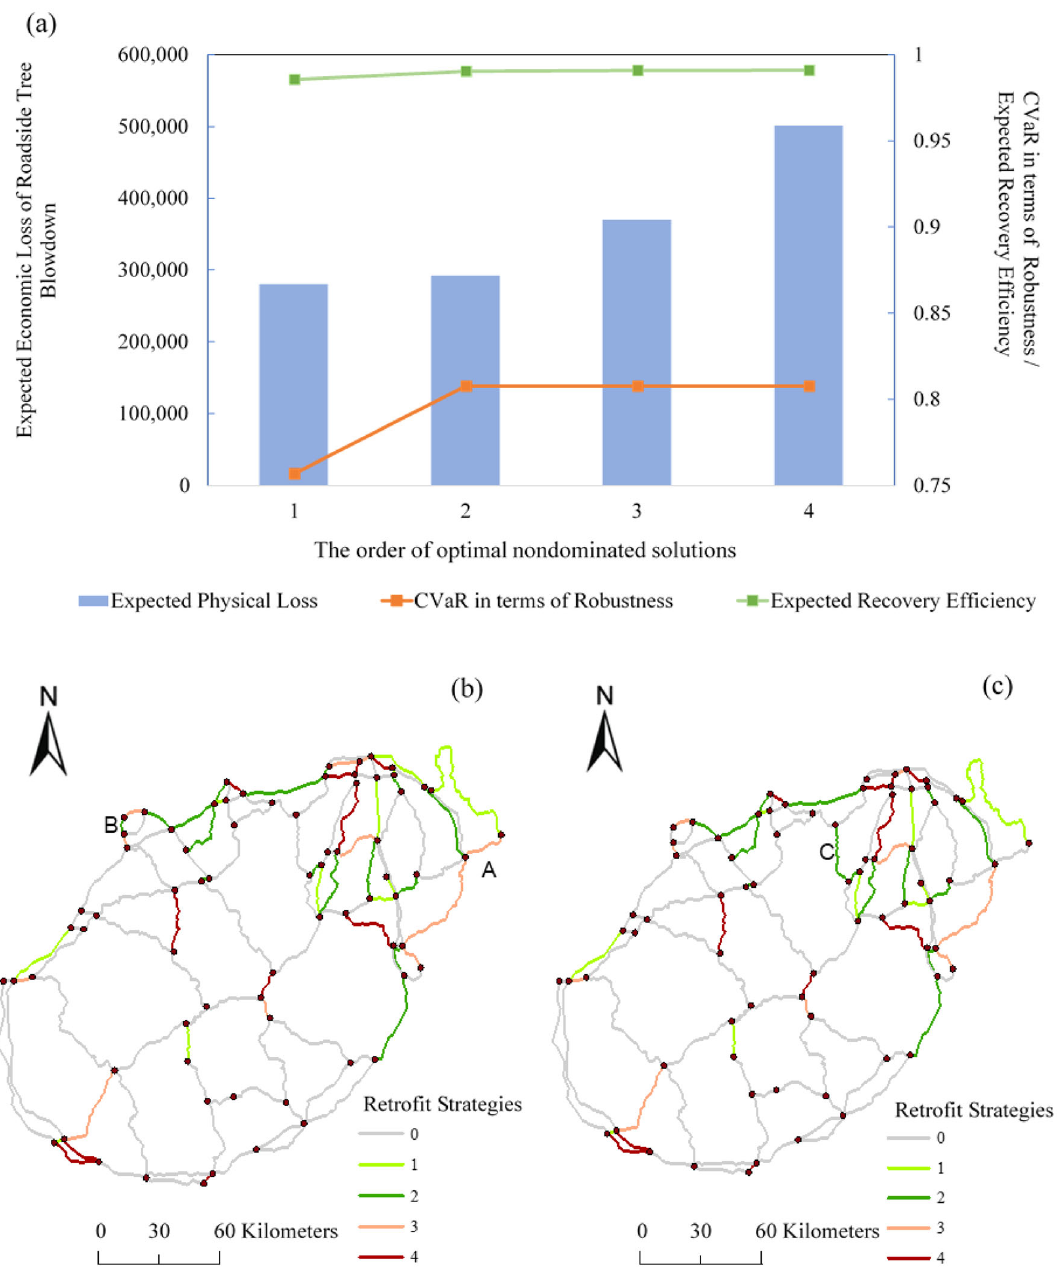
Fig. 7 Pareto-optimal solutions. a Four optimal nondominated solutions. b , c respectively are the 1st and 4th solutions of optimal nondominated